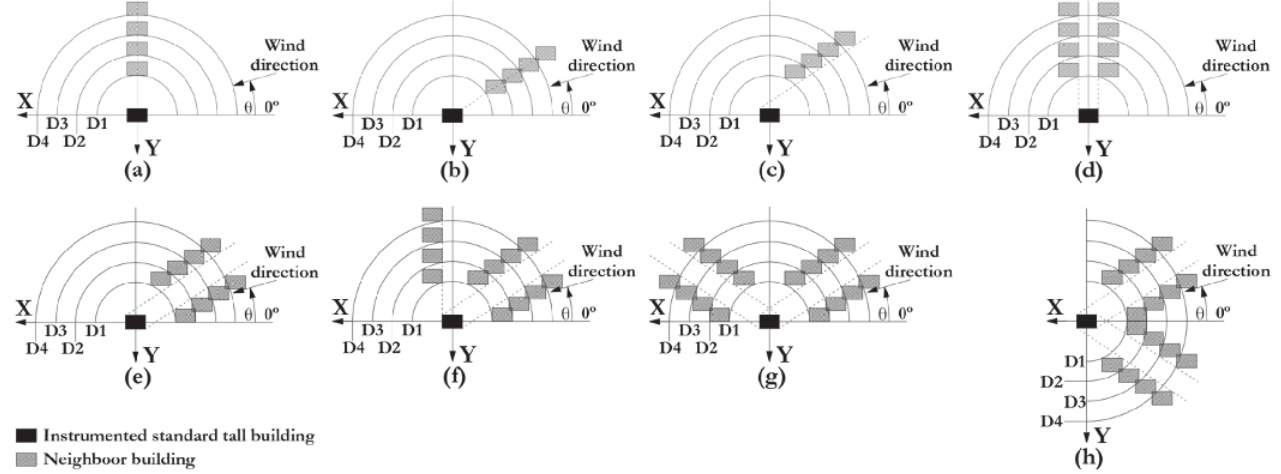
Figure 6 (a) Vicinity V1; (b) Vicinity V2; (c) Vicinity V3; (d) Vicinity V4; (e) Vicinity V5; (f) Vicinity V6; (g) Vicinity V7; (h) Vicinity